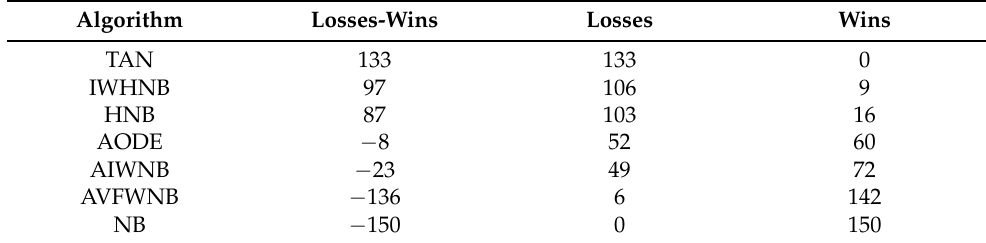
Table 6. Ranking test results on elapsed training